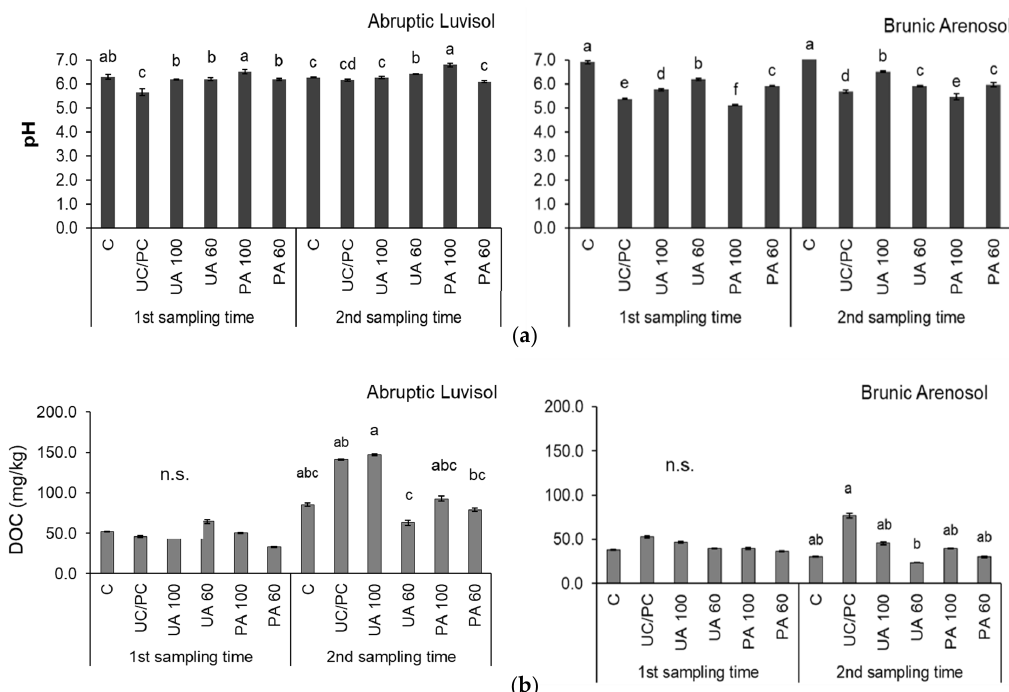
Figure 3. pH ( a ) and dissolved organic carbon content (DOC) ( b ) in Abruptic Luvisol and Brunic Arenosol collected in two terms after fertilization: I st sampling time (one week after the application of bio- and fertilizers), and II nd sampling time (six months after fertilization). Tested variants: C—control without fertilization, UC / PC—Polifoska and urea, UA 100—urea in full dose enriched with microorganisms, UA 60—urea in reduced dose enriched with microorganisms, PA 100—Polifoska in full dose enriched with microorganisms, PA 60—Polifoska in reduced dose enriched with microorganisms (average values ± standard deviation; n = 3). Di ff erent letters indicate significant di ff erences; ANOVA, Tukey HSD test, separately for each soil and for each sampling time, p < 0.05. Therefore, the increase in pH value after the addition of biofertilizers is a positive aspect of their use in degraded, acidic soils. PCA analysis showed that in both soils, pH is a stronger controller of soil biological activity than DOC content (Figure 4) in which significant changes were observed only in samples collected in II nd sampling time (Figure 3b).